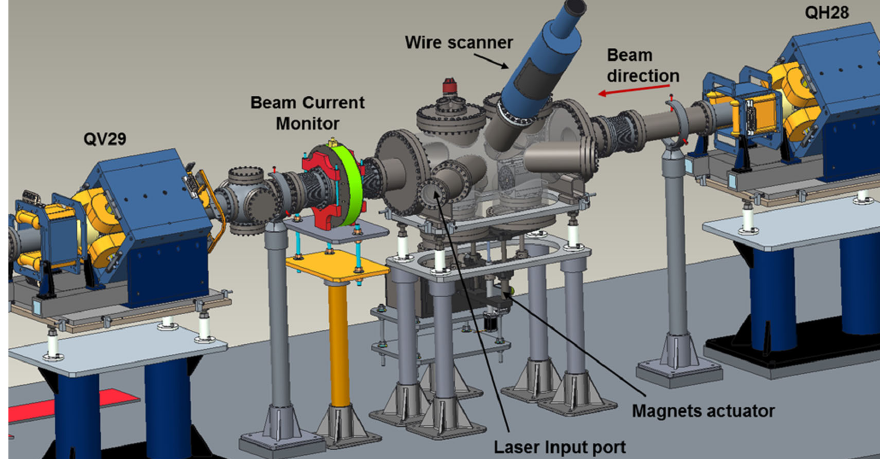
FIG. 18. A layout of the interaction point experimental setup of the laser stripping experiment.